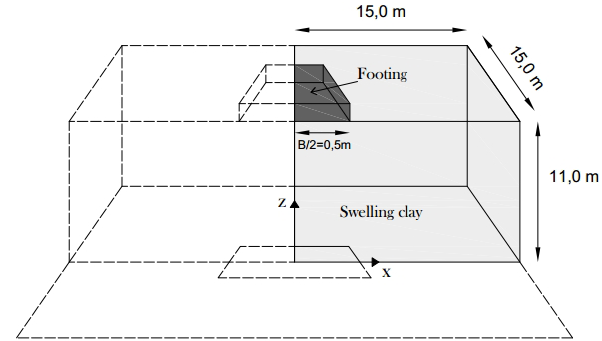
Figure 6: Geometry of the